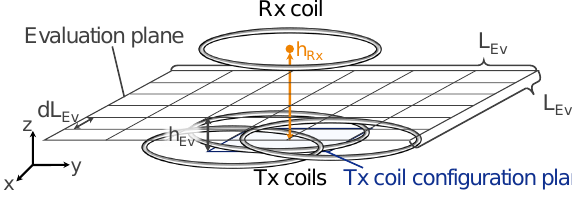
Figure 5. Evaluation points in the evaluation